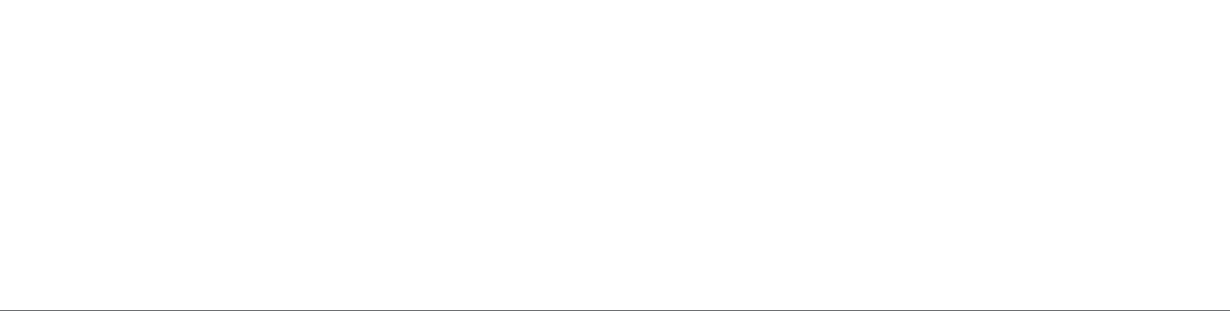
Frontiers in Cell and Developmental Biology |